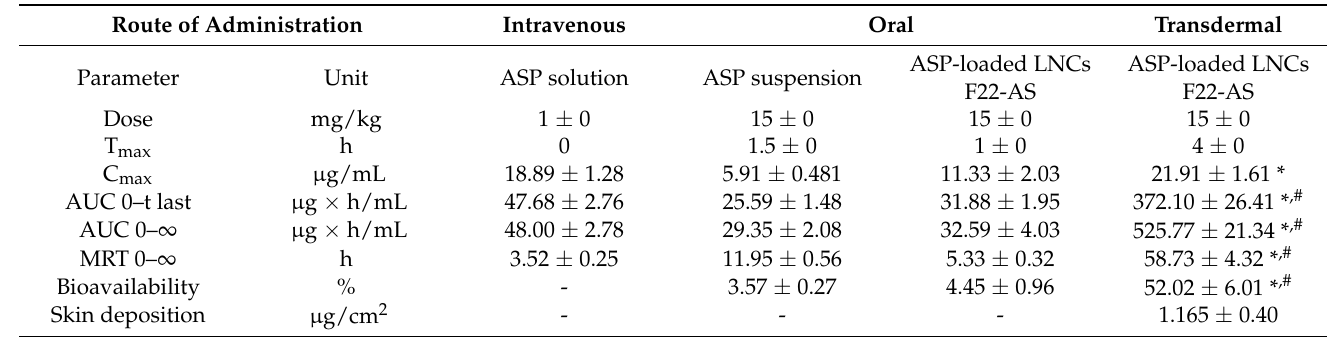
Table 3. In vivo pharmacokinetic parameters of transdermal application of optimized ASP-loaded LNCs compared to intravenous and oral